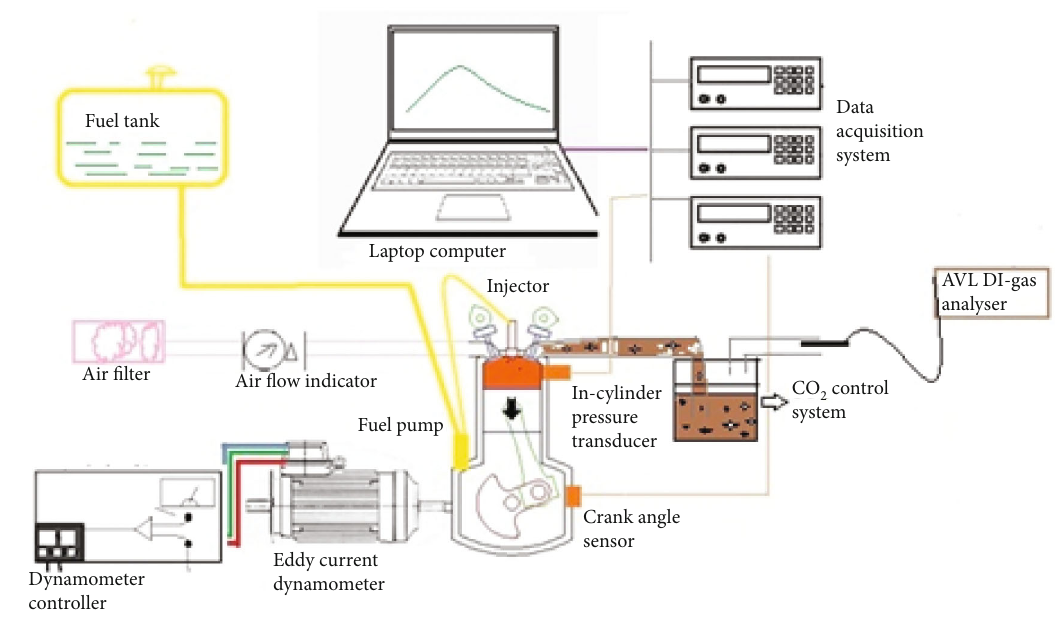
Figure 5: Layout of experimental test bench.